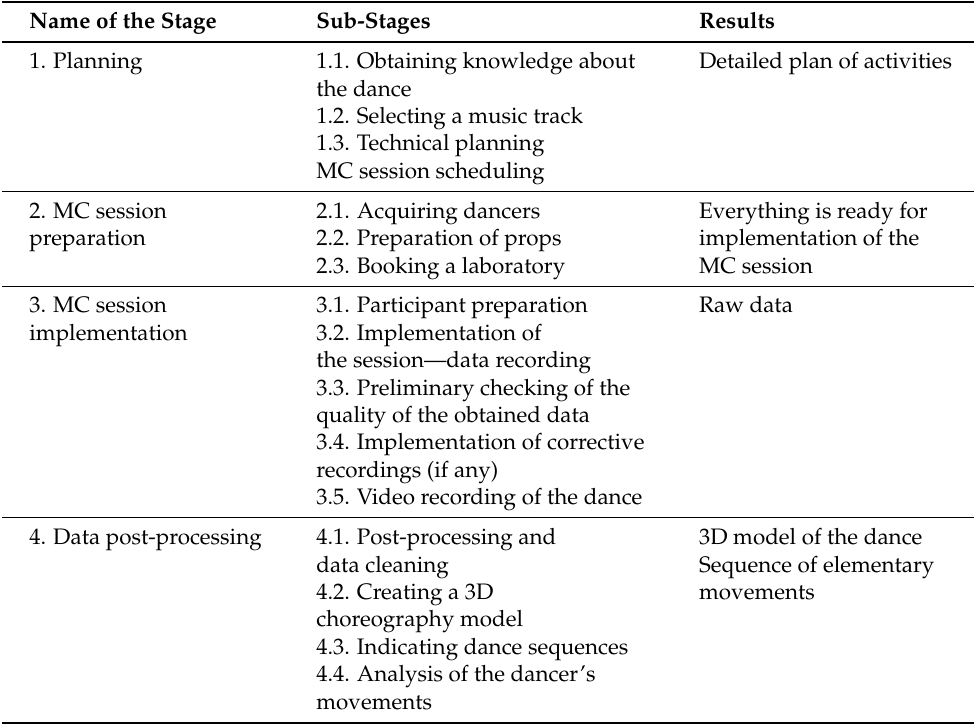
Table 3. Methodology of 3D digitisation of dance